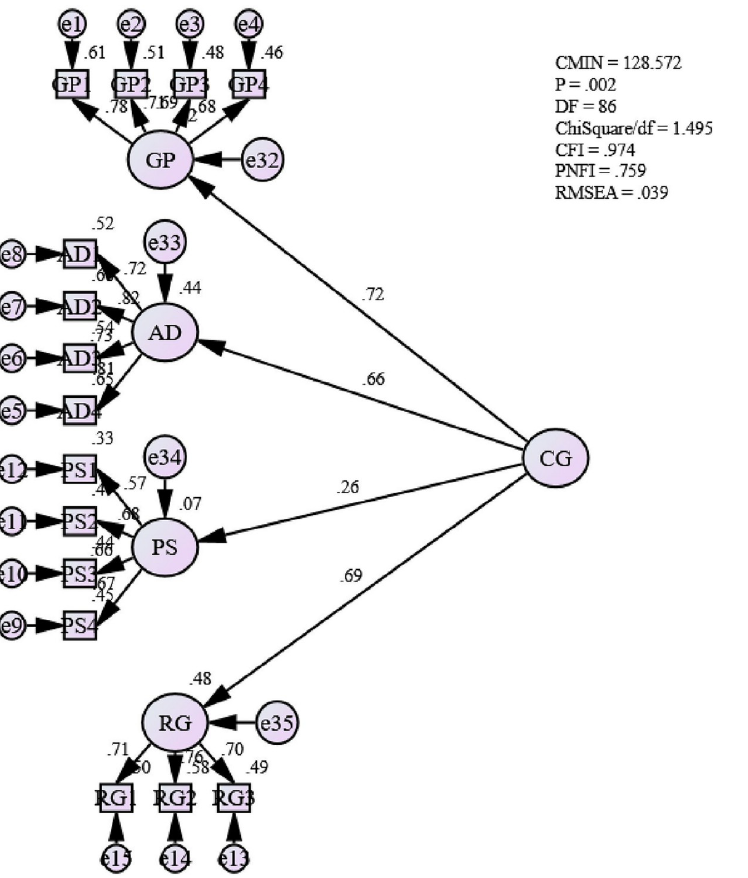
Fig 2. Measurement model for career